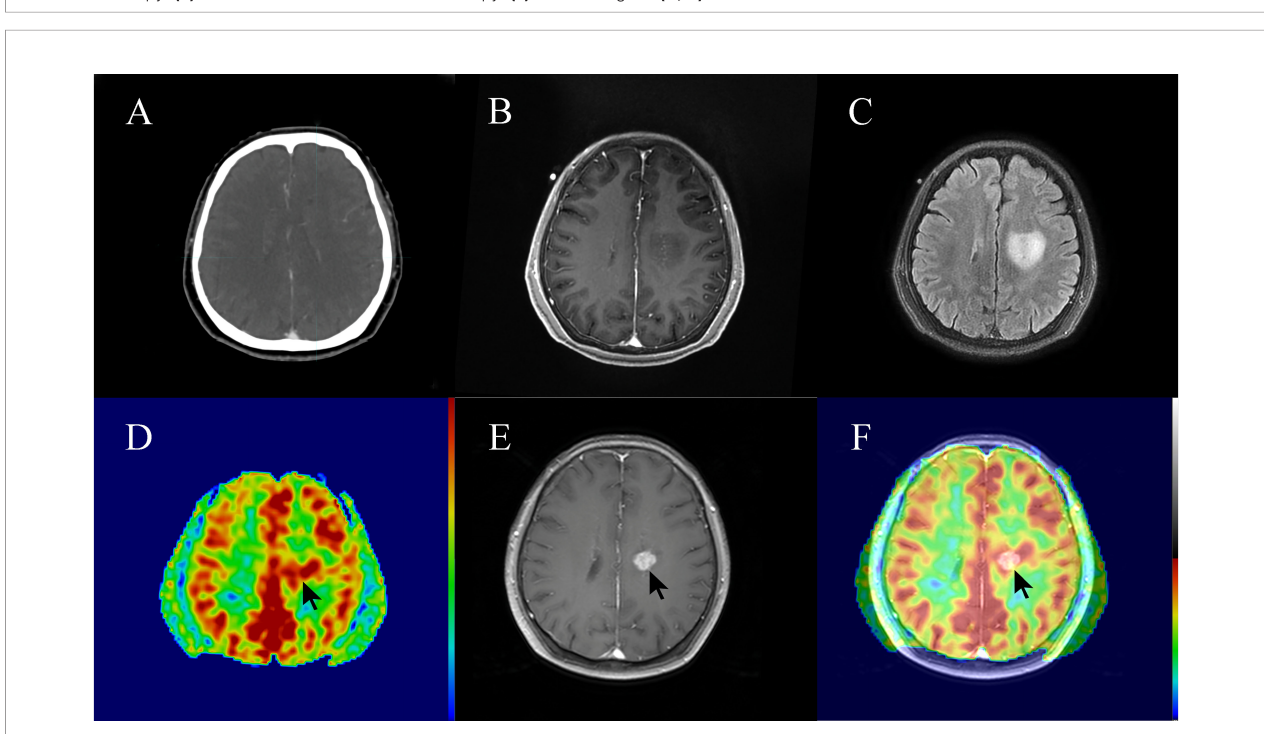
FIGURE 6 | A 62-year-old patient with non-enhancing low-grade glioma (WHO grade II astrocytoma) showed focal post-radiotherapy contrast enhancement within a prior non-enhanced and high-perfusion area at 3 months following radiotherapy. The patient had clinical symptoms such as weakness of the right lower limb, considering the tumor progression. (A) Planning contrast-enhanced CT (CE-CT) image. (B) Contrast-enhanced T1-weighted imaging (CE-T1WI) before radiotherapy. (C) T2 fl uid-attenuated inversion recovery (T2 Flair) image before radiotherapy. (D) three-dimensional arterial spin labeling (3D-ASL) image before radiotherapy. (E) CE-T1WI at 3 months following radiotherapy. (F) Fusion image of (D, E) .